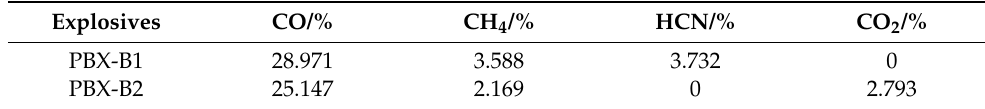
Table 2. Gaseous products of explosion in the air condition.